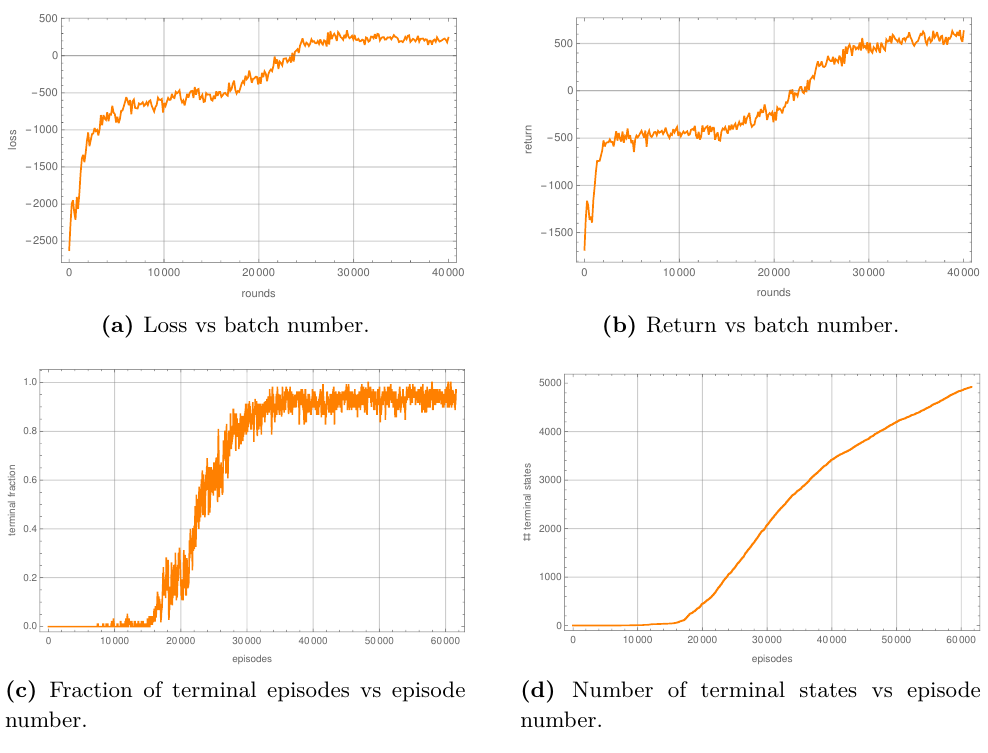
Figure 1. Training measurements for the case of a single U(1) and − q min = q max = 9